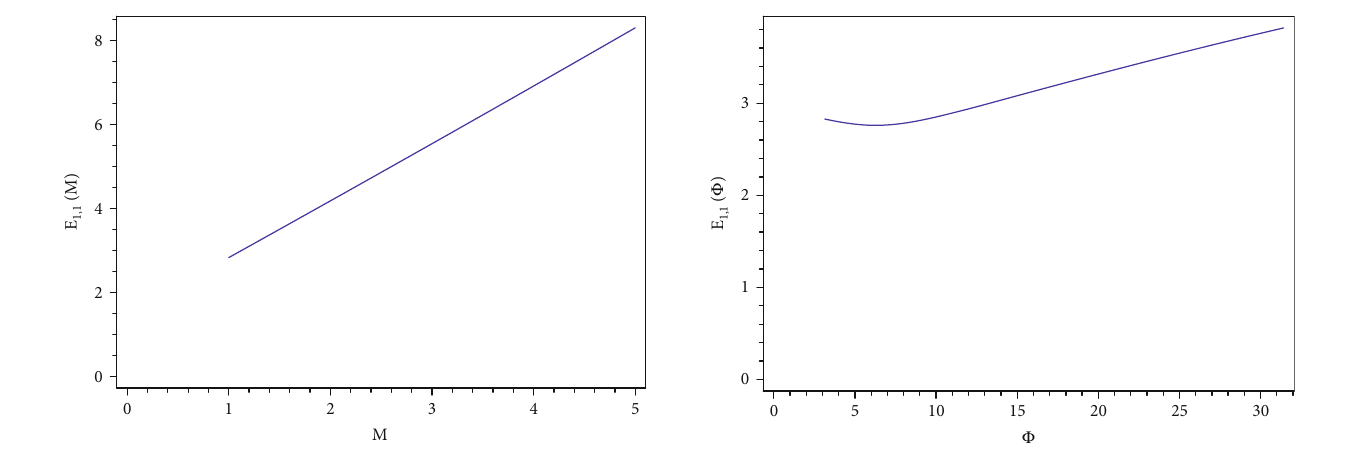
Figure 7: n = l = k = q = a = b = η